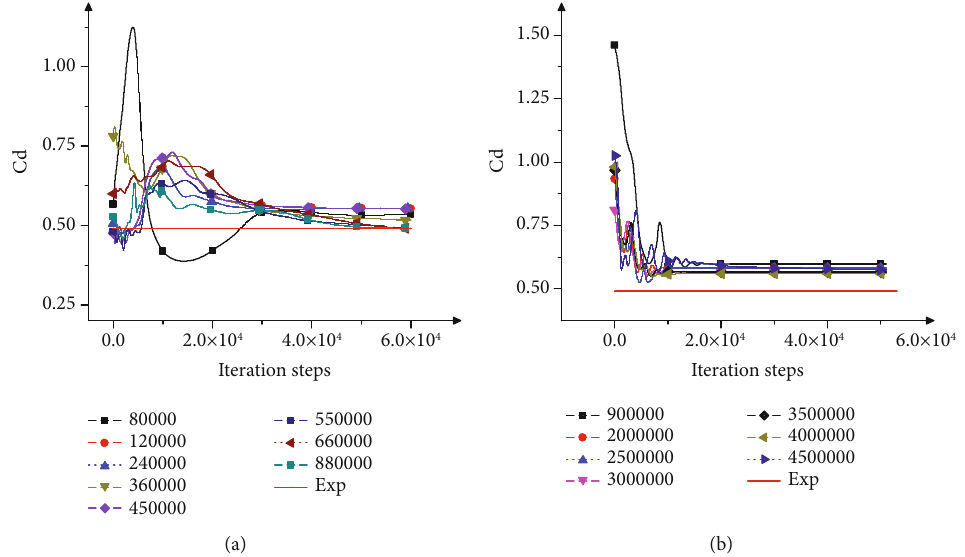
Figure 4: Numerical simulation results for two cases with di ff erent numbers of mesh and experimental data. (a) two-dimensional and (b)